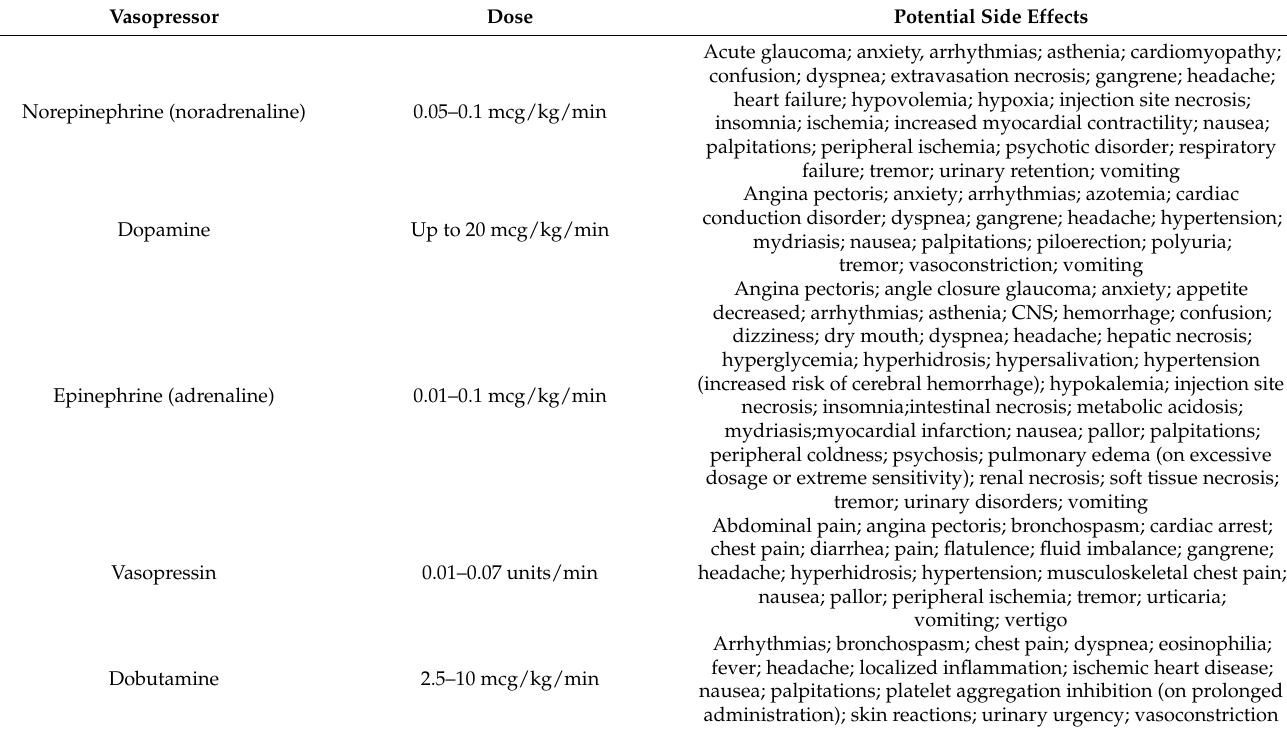
Table 2. Studies with CytoSorb and control